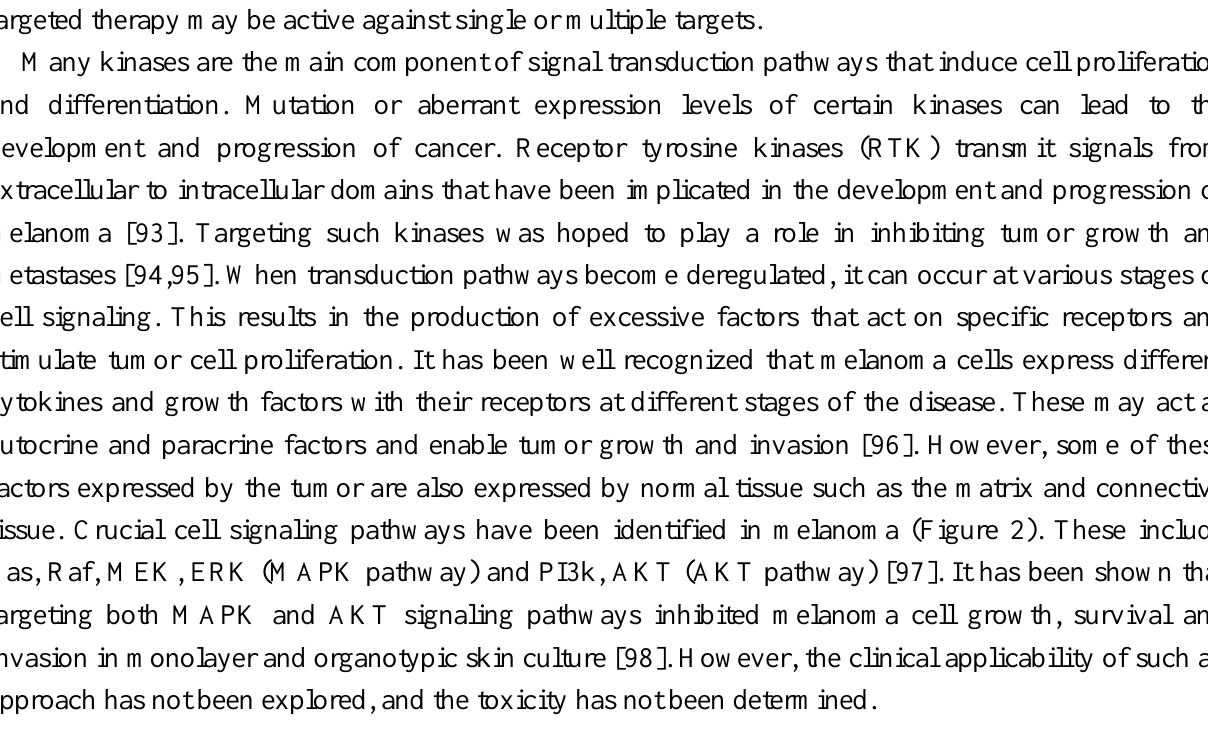
Figure 2. Targeting of the crucial cell signaling pathways of MAPK and AKT has been tested in organotypic skin